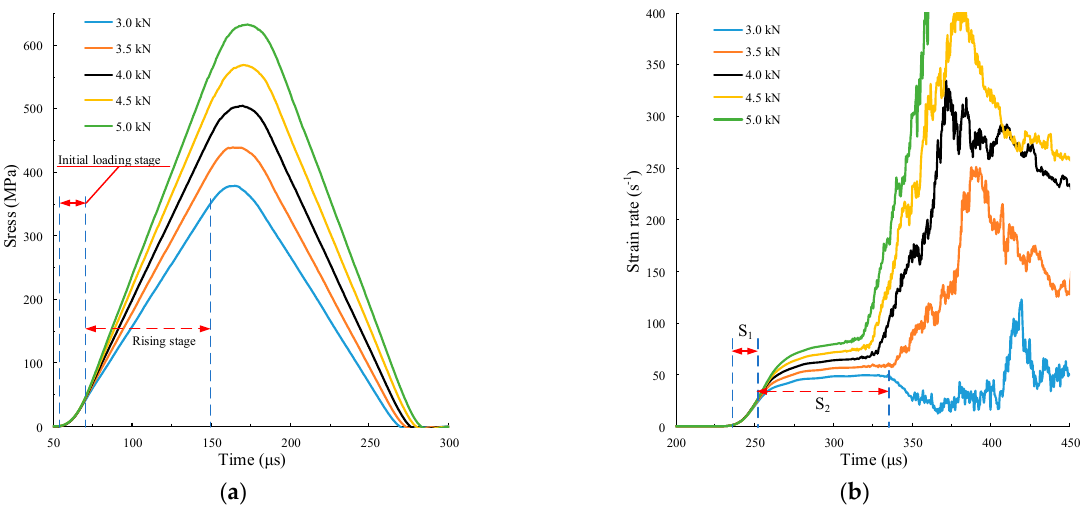
Figure 10. Calculation curve under different amplitudes. ( a ) Time history curves of incident stress wave; ( b ) time history curves of strain rate.